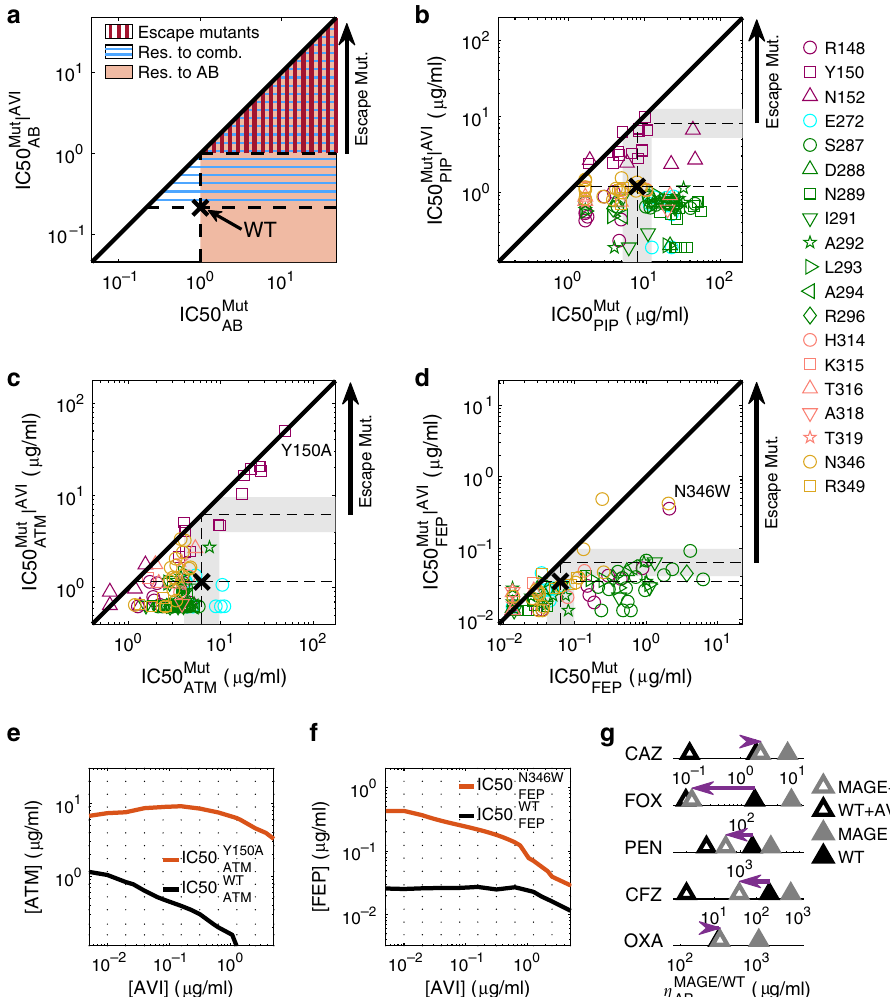
Fig. 5 Escape mutations are rare and drug-speci fi c. a Areas in the concentration space of an antibiotic, AB, and antibiotic-AVI combination are highlighted by the resistance required to grow in them. Antibiotic-resistant mutations (orange shade, mutants are more resistant to the AB than the WT), combination- resistant mutations (blue horizontal lines, more resistant to AB than WT in the presence of AVI) and escape mutations (red vertical lines, more resistant to AB in presence of AVI than WT is to AB without AVI). b – d Mutants plotted according to their resistance to PIP (b), ATM (c), and FEP (d), when applied in isolation or supplemented with 0.25 μ g/ml AVI. While no escape mutants appeared for PIP, a small subset of the mutants escaped the ATM-AVI or the